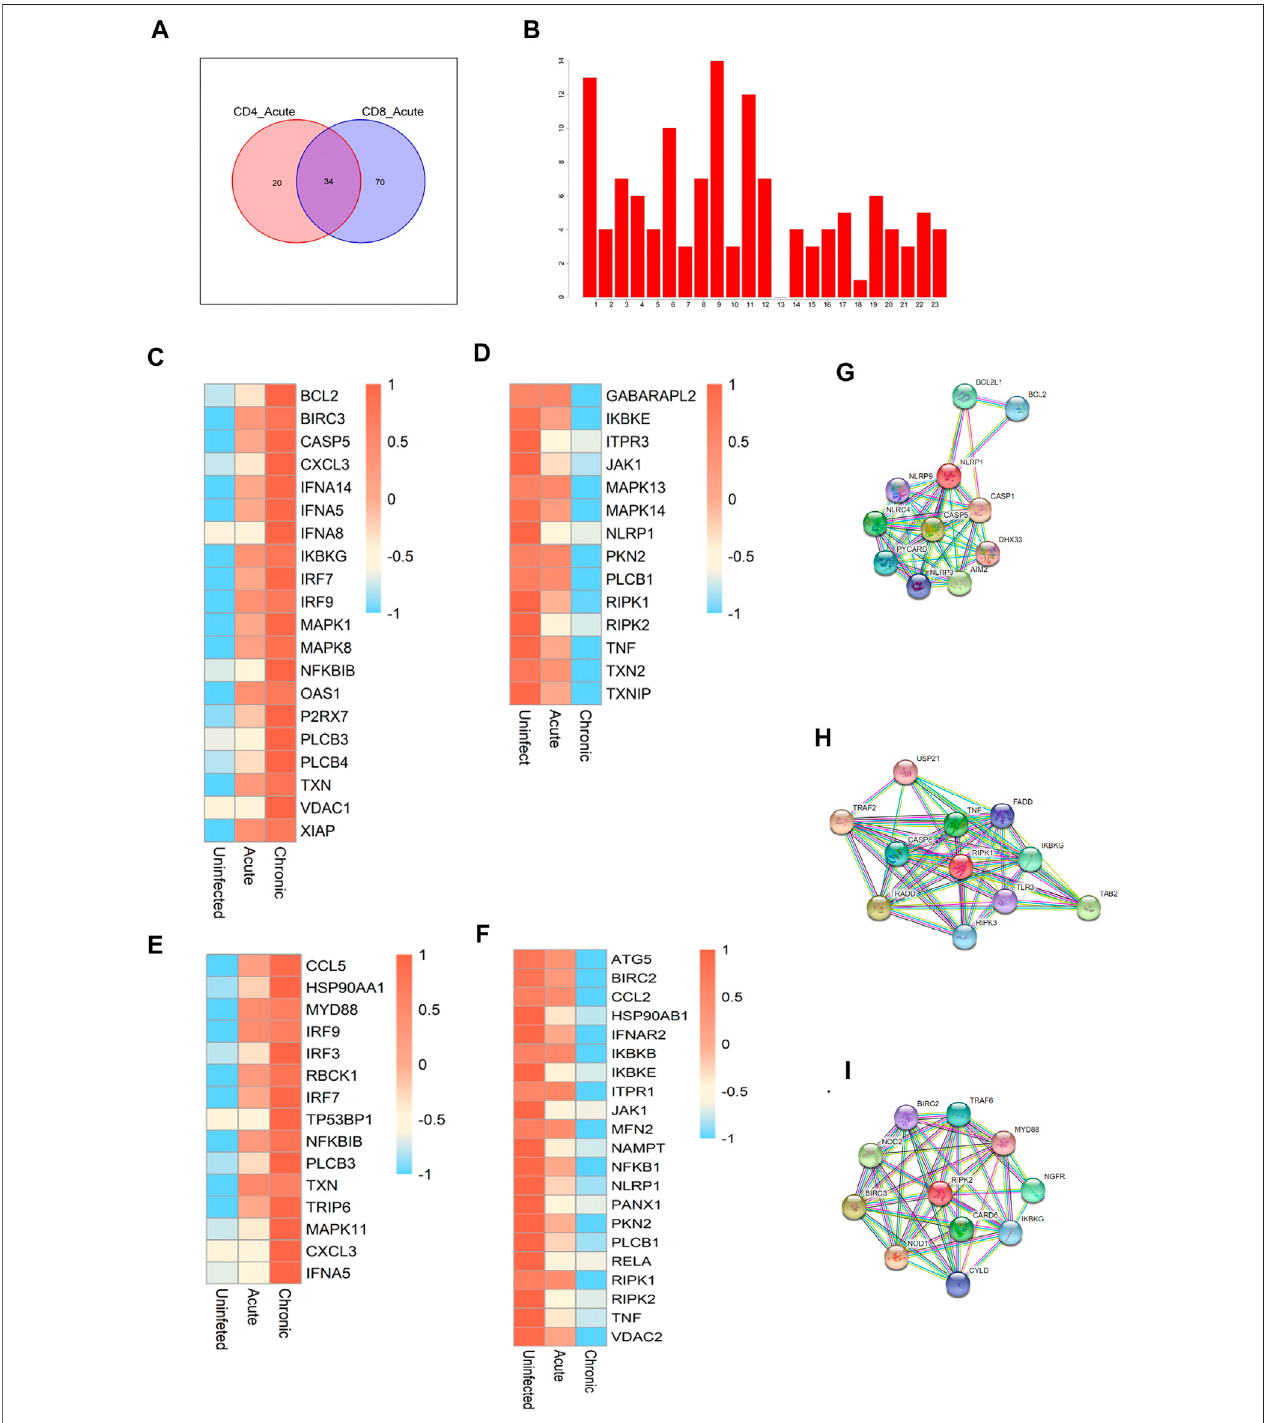
FIGURE 3 | Critical pathways during acute HIV infection. (A) Enrichment of pathways in CD4 + and CD8 + T cells during the early stage of HIV infection. The Venn diagram shows a total of 34 pathways common to the two cell types, with 20 CD4 + T cell-speci fi c pathways and 70 CD8 + T cell-speci fi c pathways. (B) Chromosomal localisation of all genes in the NOD-like receptor pathway. (C,D) Gene modules and co-upregulated gene modules in the NOD-like receptor pathway in CD4 + T cells during different infection periods. (E,F) Co-upregulated and co-downregulated gene modules in CD8 + T cells during different HIV infection periods. (G – I) Protein- protein interaction network centralised with respect to NLRP1 (G) , RIPL1 (H) , and RIPK2 (I) .